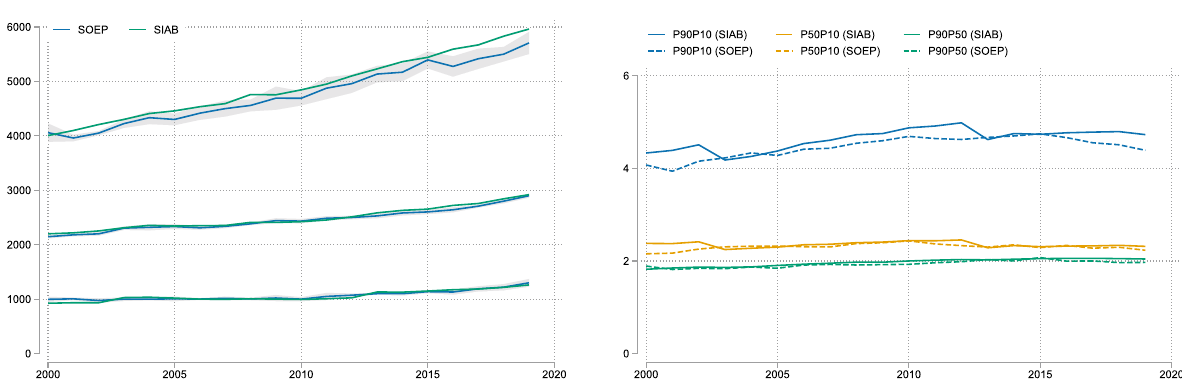
Fig. 5 Monthly wages in 2000–2019; sample: comparable sample; only wages above marginal part-time employment. Source: own calculations, SOEP-Core.v37.EU & SIAB 7519. 95% confidence interval indicated by shaded areas (for percentiles only); 500 bootstrap replications